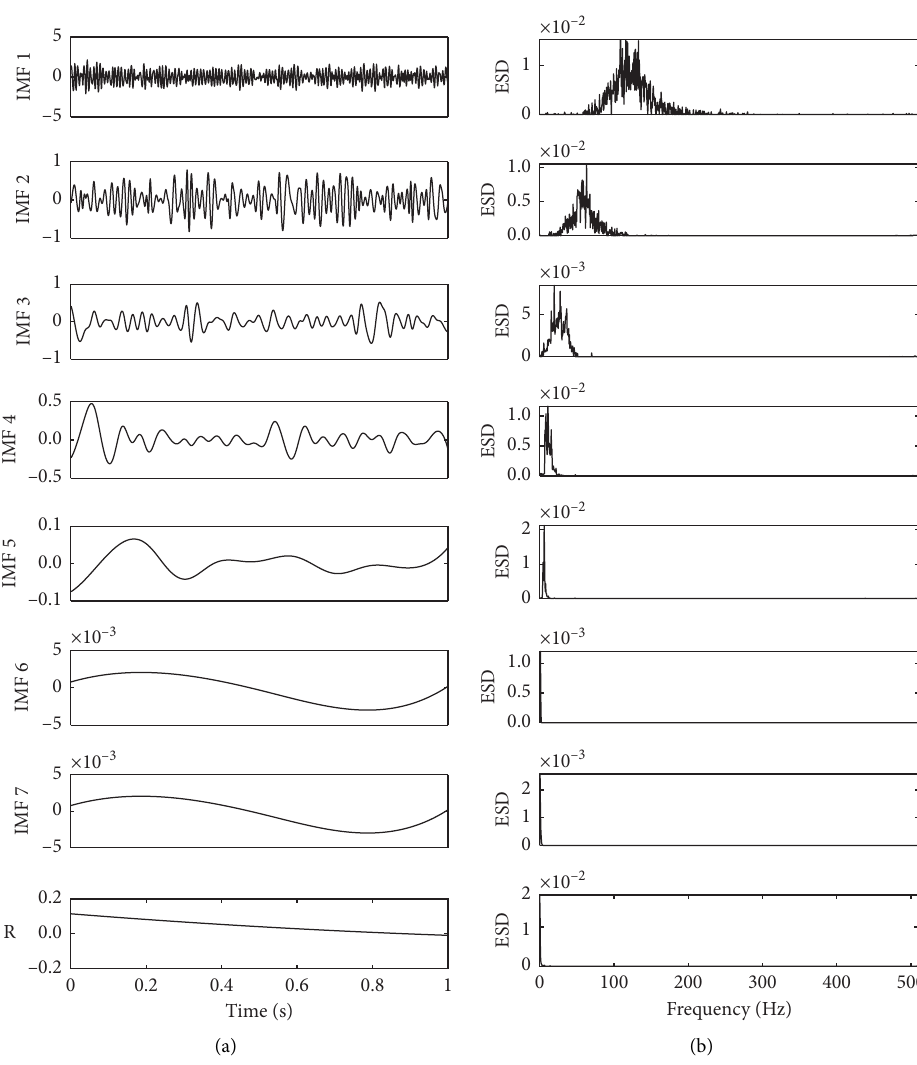
Figure 4: Results of CEEMD-HT time-frequency analysis. (a) Decomposition results of EMD. (b) IMF marginal